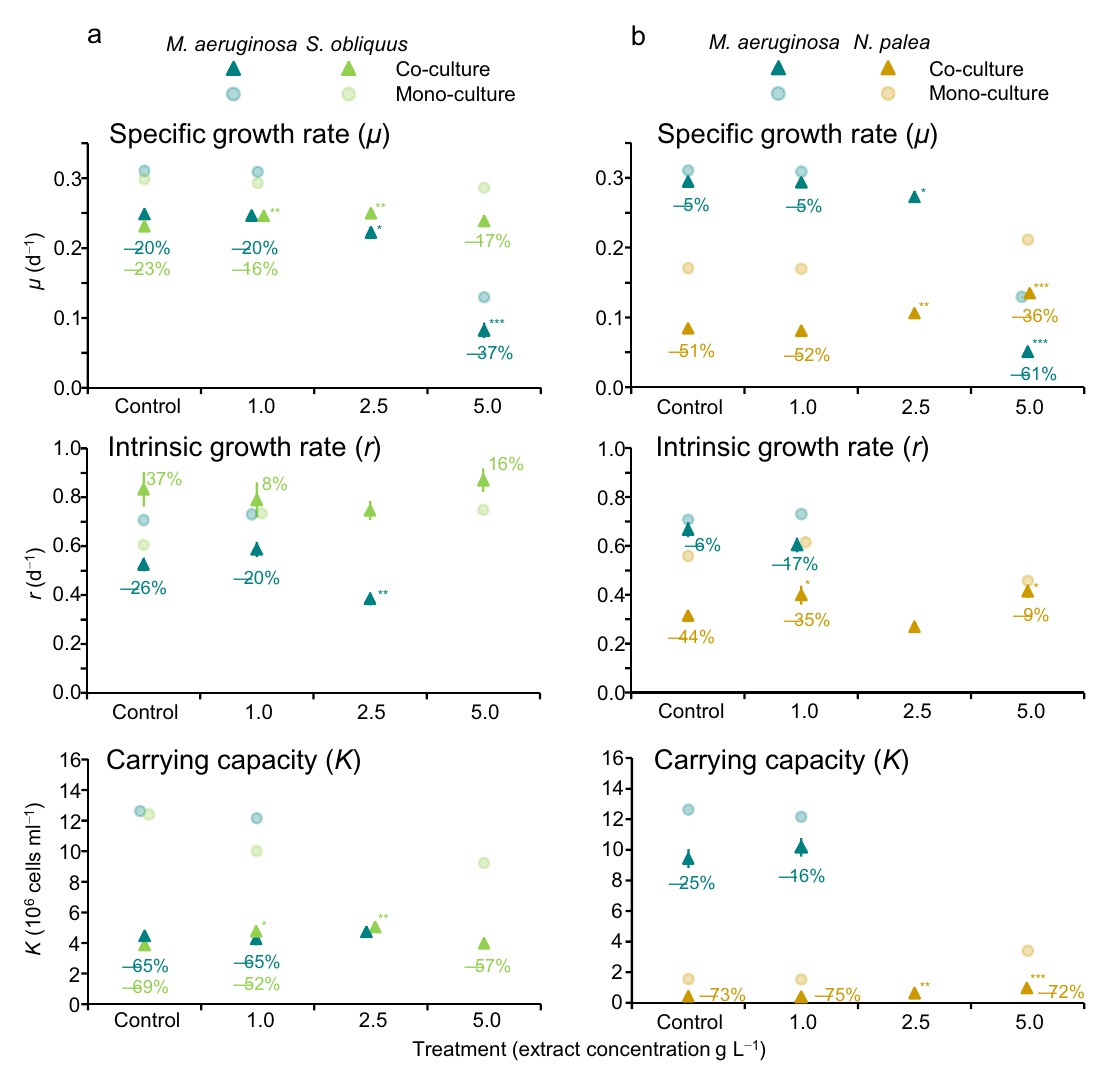
Figure 4. Growth parameters ( μ , r , K ) calculated for each species in different treatments in co-culture systems (a: Microcystis aeruginosa and Scenedesmus obliquus , b: M. aeruginosa and Nitzschia palea ). Error bars are SD ( n = 3). Asterisks denote a significant difference between the control and extract treatments for each species (Dunnett’s test, * : p < 0.05, ** : p < 0.01, *** : p < 0.001). Growth parameters of each species in the mono-culture and percentage decrease from mono- to co-culture systems for each parameter are also shown. Values of r and K were not obtained for M. aeruginosa in some